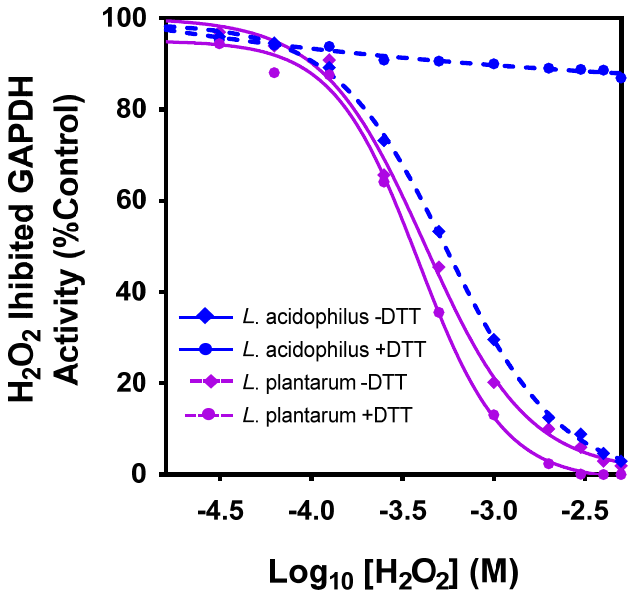
Figure 3. Inactivation of GAPDH in H 2 O 2 − secreting and non − secreting Lactobacilli . Dose–response of H 2 O 2 inhibition of GAPDH activity in cytosol extracts from L . plantarum , a non H 2 O 2 secreting species and L . plantarum , an H 2 O 2 secreting species measured in the presence and absence of DTT in the assay buffer. IC 50 values for H 2 O 2 inhibition of GAPDH activity calculated from 4 − parameter logistic regression analysis of the data The recovery of enzyme activity in the presence of DTT in the species with a C v S replacement ( L. acidophilus ) supports the premise that C v (SH) is required for the thiol − irreversible GAPDH inactivation by H 2 O 2.